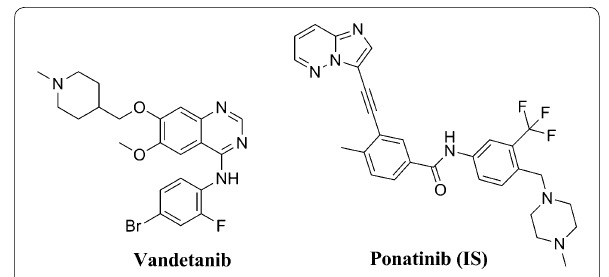
Fig. 1 Chemical structure of Vandetanib and Ponatinib